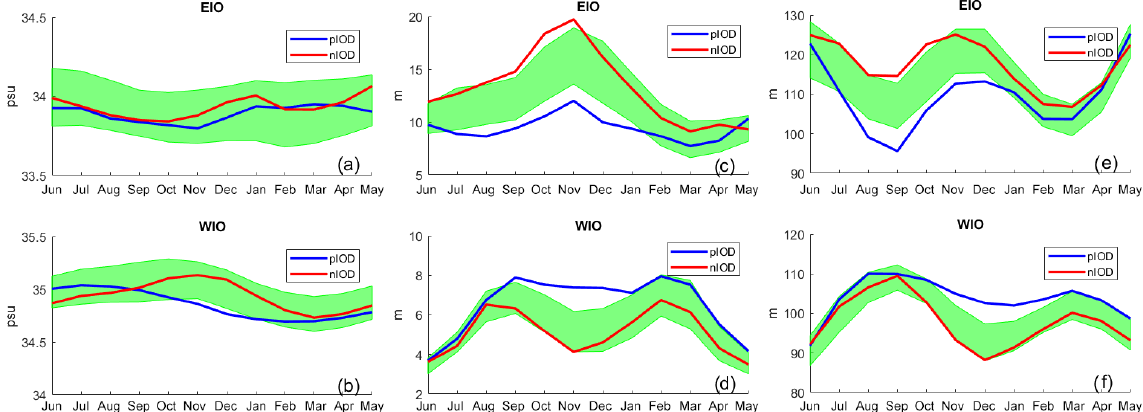
Figure 9. The compositing seasonal variations of SSS ( a, b ; unit: psu), BLT ( c, d ; unit: m), and the thermocline depth ( e, f ; unit: m) in IOD events during the period of 1980–2015 averaged by the areas of the eastern TIO (EIO; 12 ◦ S–5 ◦ N, 85–100 ◦ E) and the western TIO (WIO; 12 ◦ S–5 ◦ N, 55–75 ◦ E), separately. The blue line represents the composite in positive IOD events and the red one represents that in negative IOD events; the green shaded area represents the 95% Monte Carlo significance level.